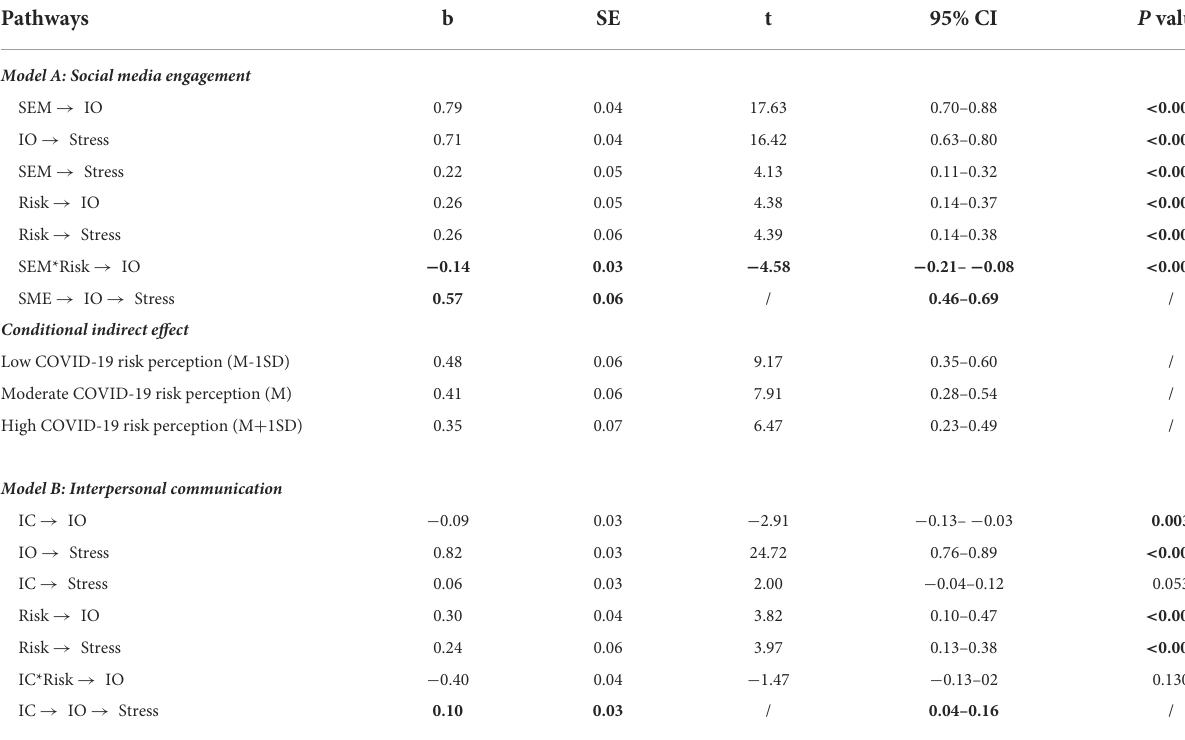
TABLE 3 Moderation and mediation analysis results by using PROCESS